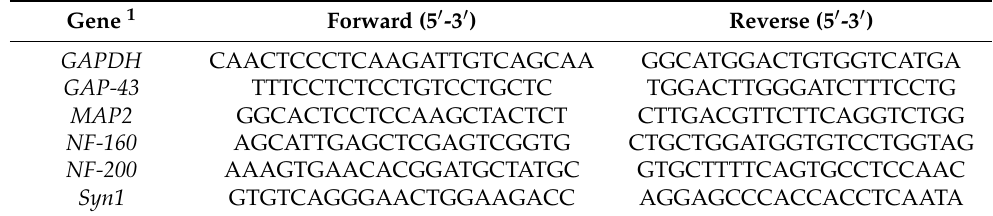
Table 3. Primer sequences used for RT-PCR procedures 1